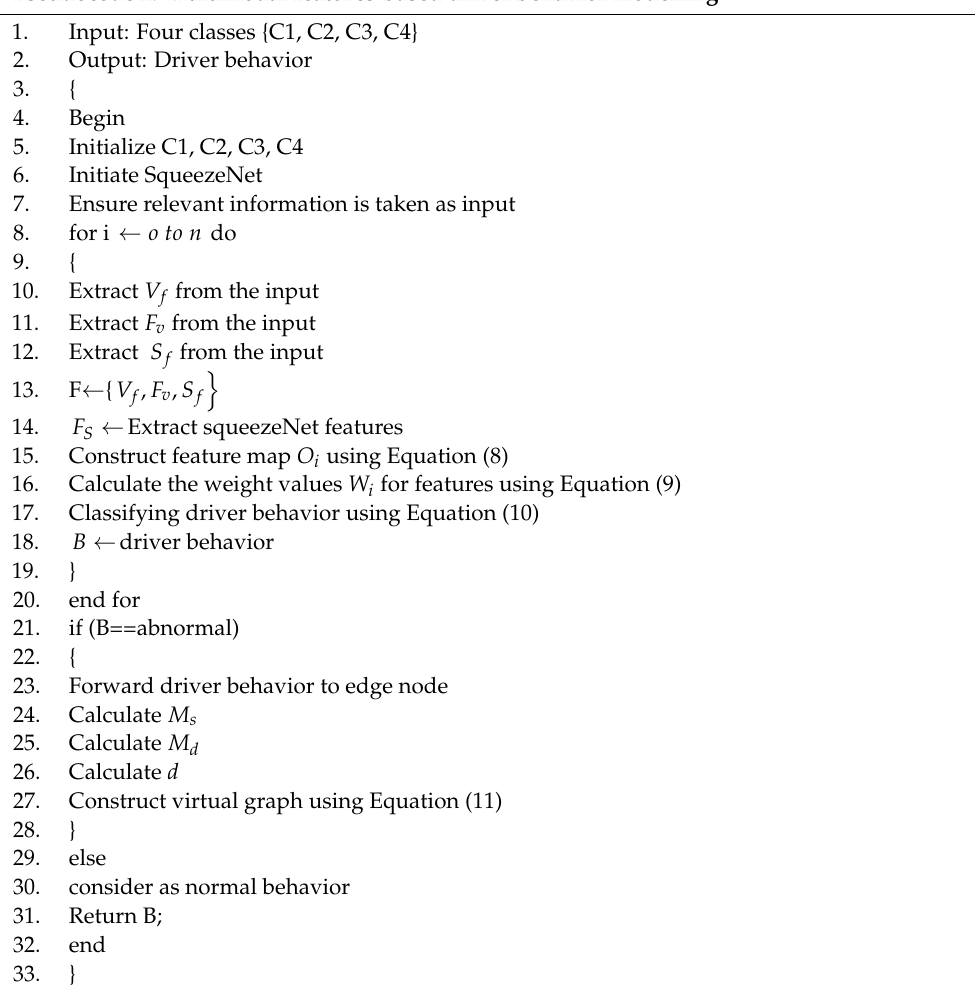
Pseudocode 2: Multimodal features-based driver behavior